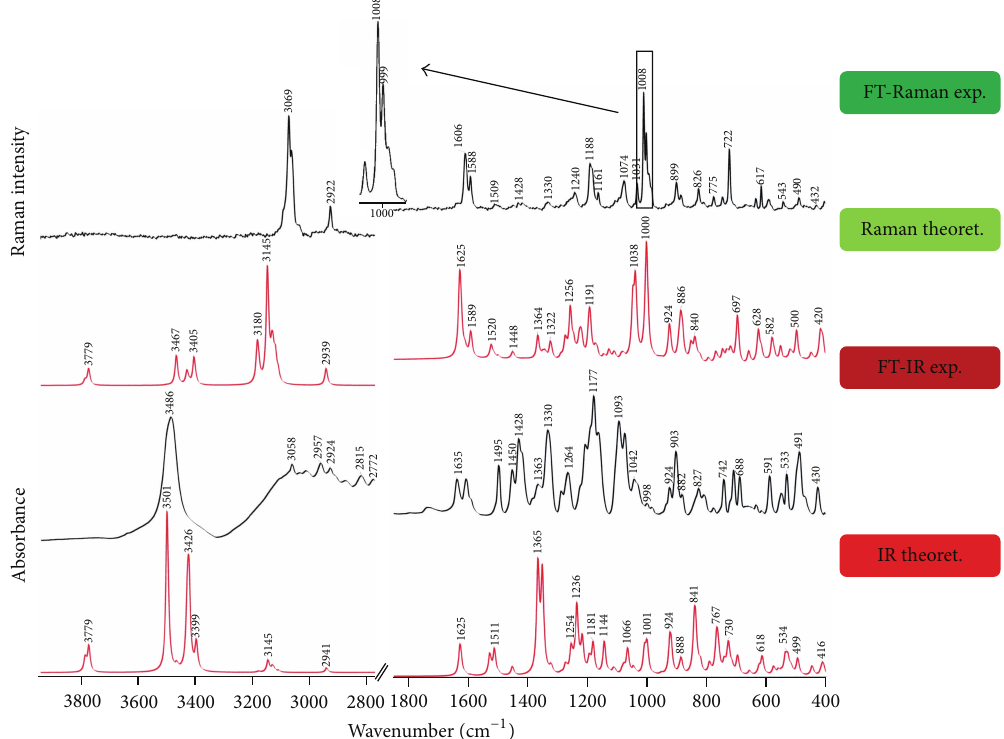
Figure 2: The experimental and theoretical FT-Raman and FT-IR spectra of [PhN-(2-PhB(OH) 2 )- R -Me]PO 3 H 2 in the spectral range of 3650–400 cm −1